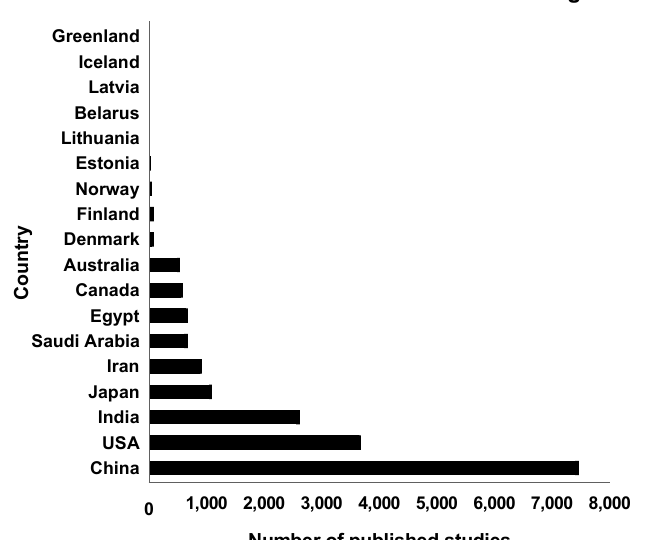
Figure 1. The number of studies published in different countries and indexed in the PubMed database with the keywords “natural” and “anticancer” (as of June 13th,